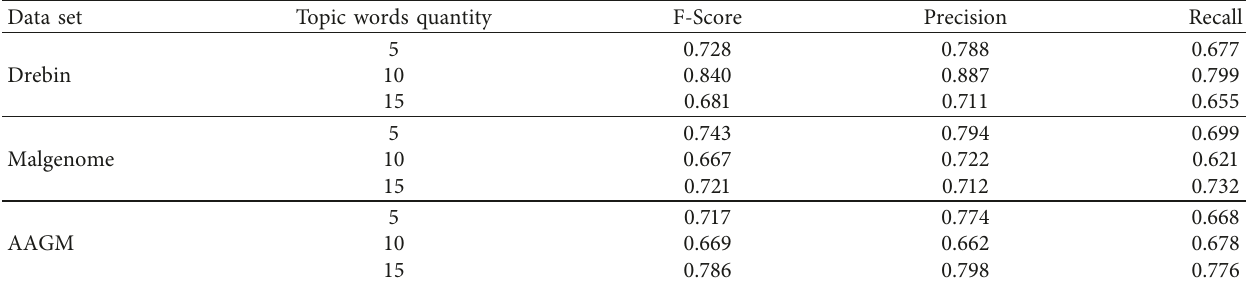
Table 13: Performance metric outcomes for topic words